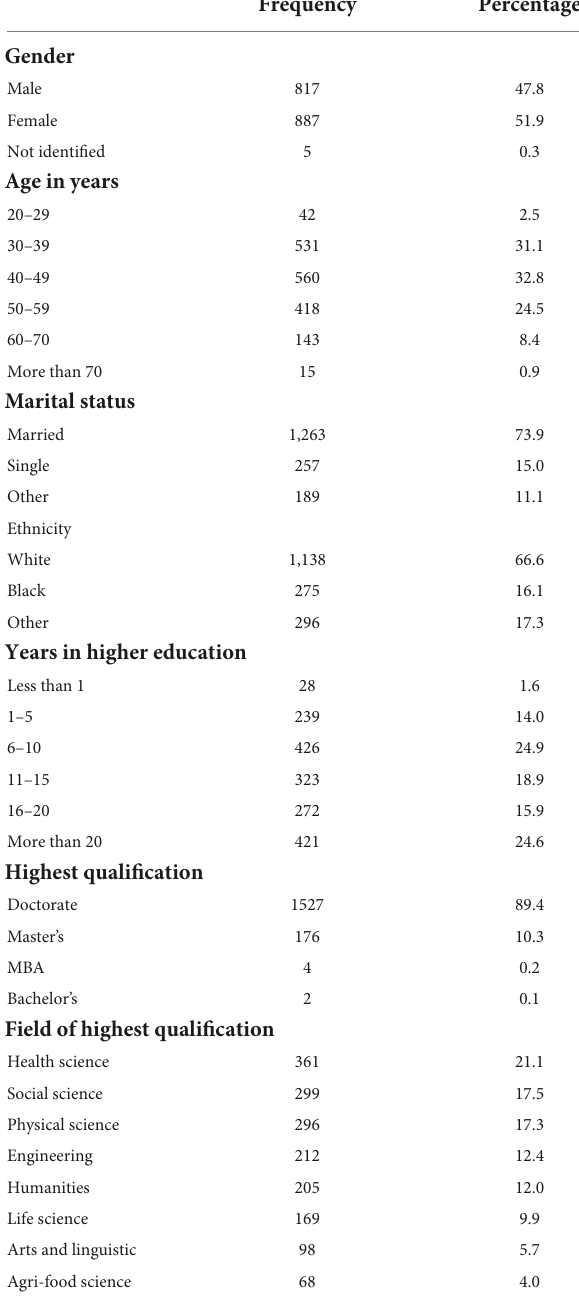
TABLE 1 Frequencies and percentages of participant characteristics ( N =